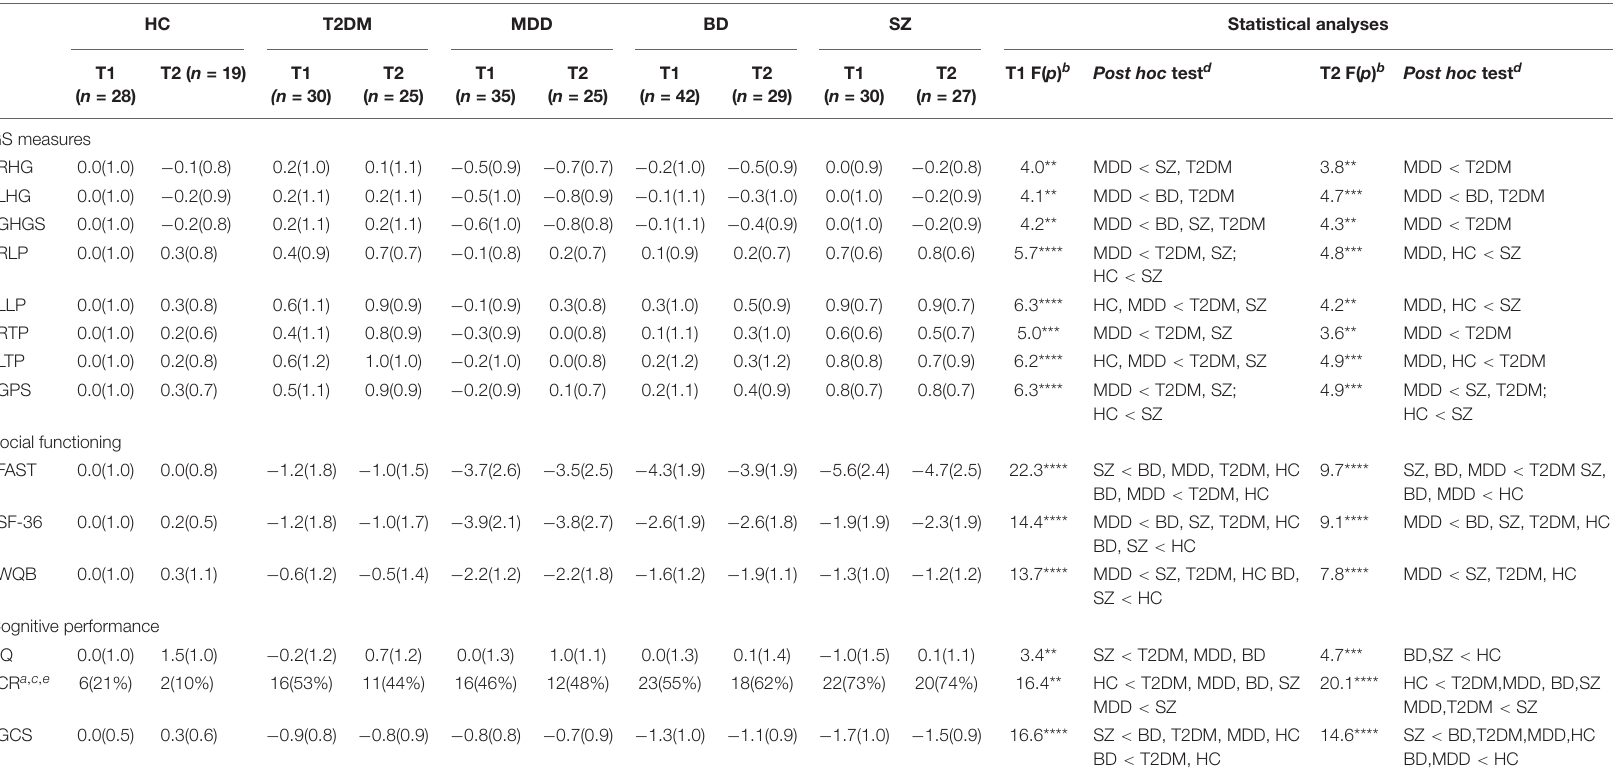
Expressed as mean (standard deviation) except when indicated. a Low n(%). b ANCOVA. c Chi-squared test. d Bonferroni test. e Mann–Whitney U test.HC, healthy control; T2DM, type-2 diabetes mellitus; MDD, major depressive disorder; BD, bipolar disorder; SZ, schizophrenia; T1, Time 1; T2, Time 2; RHG, right handgrip; LHG , left handgrip; GHGS, Global Handgrip Score; RLP, right lateral/key pinch; LLP, left lateral/key pinch; RTP, right tip pinch; LTP, left tip pinch; GPS, Global Pinch Score; WQB, WHO-QoL-BREF; IQ, Intelligence Quotient; CR, cognitive reserve; GCS, Global Cognitive Score; ANCOVA, analysis of covariance; SF-36, Short-form 36; FAST, Functional Assessment Short Test; NS, not significant. NS p > 0.05; *p ≤ 0.05; **p ≤ 0.01; ***p ≤ 0.001; and ****p ≤